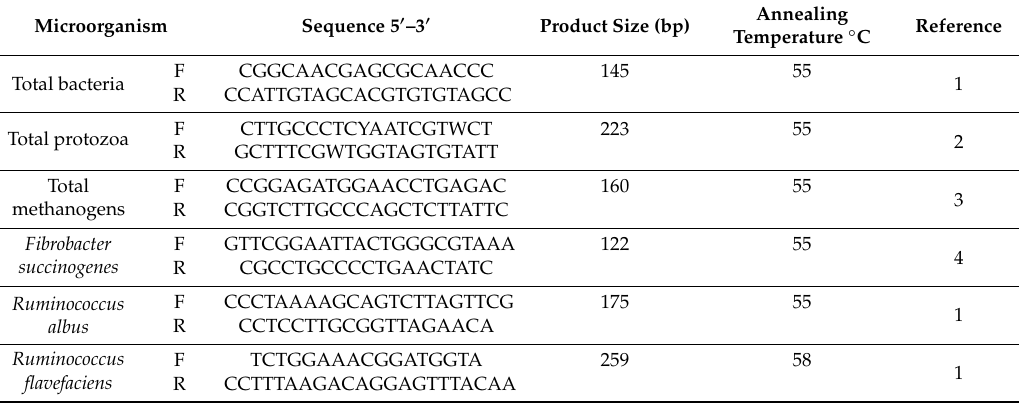
Table 3. Primers used for quantitative real-time polymerase chain reaction (q-PCR). Microorganism